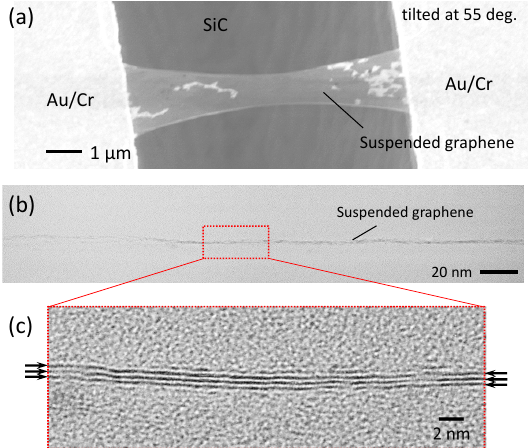
Figure 1. ( a ) Scanning electron microscopy (SEM) image (tilted at 55 ◦ ) of the doubly-clamped suspended graphene. ( b ) Low and ( c ) High magnification cross-sectional TEM images of the suspended graphene. Black arrows in (c) indicate graphene layers. Adapted from [11]. Copyright (2013) The Japan Society of Applied